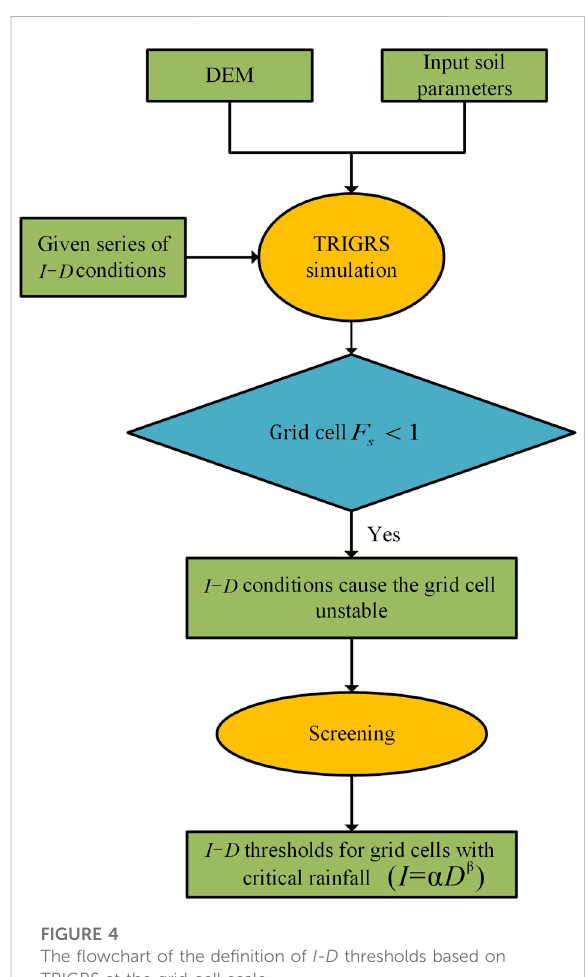
FIGURE 4 The fl owchart of the de fi nition of I-D thresholds based on TRIGRS at the grid cell